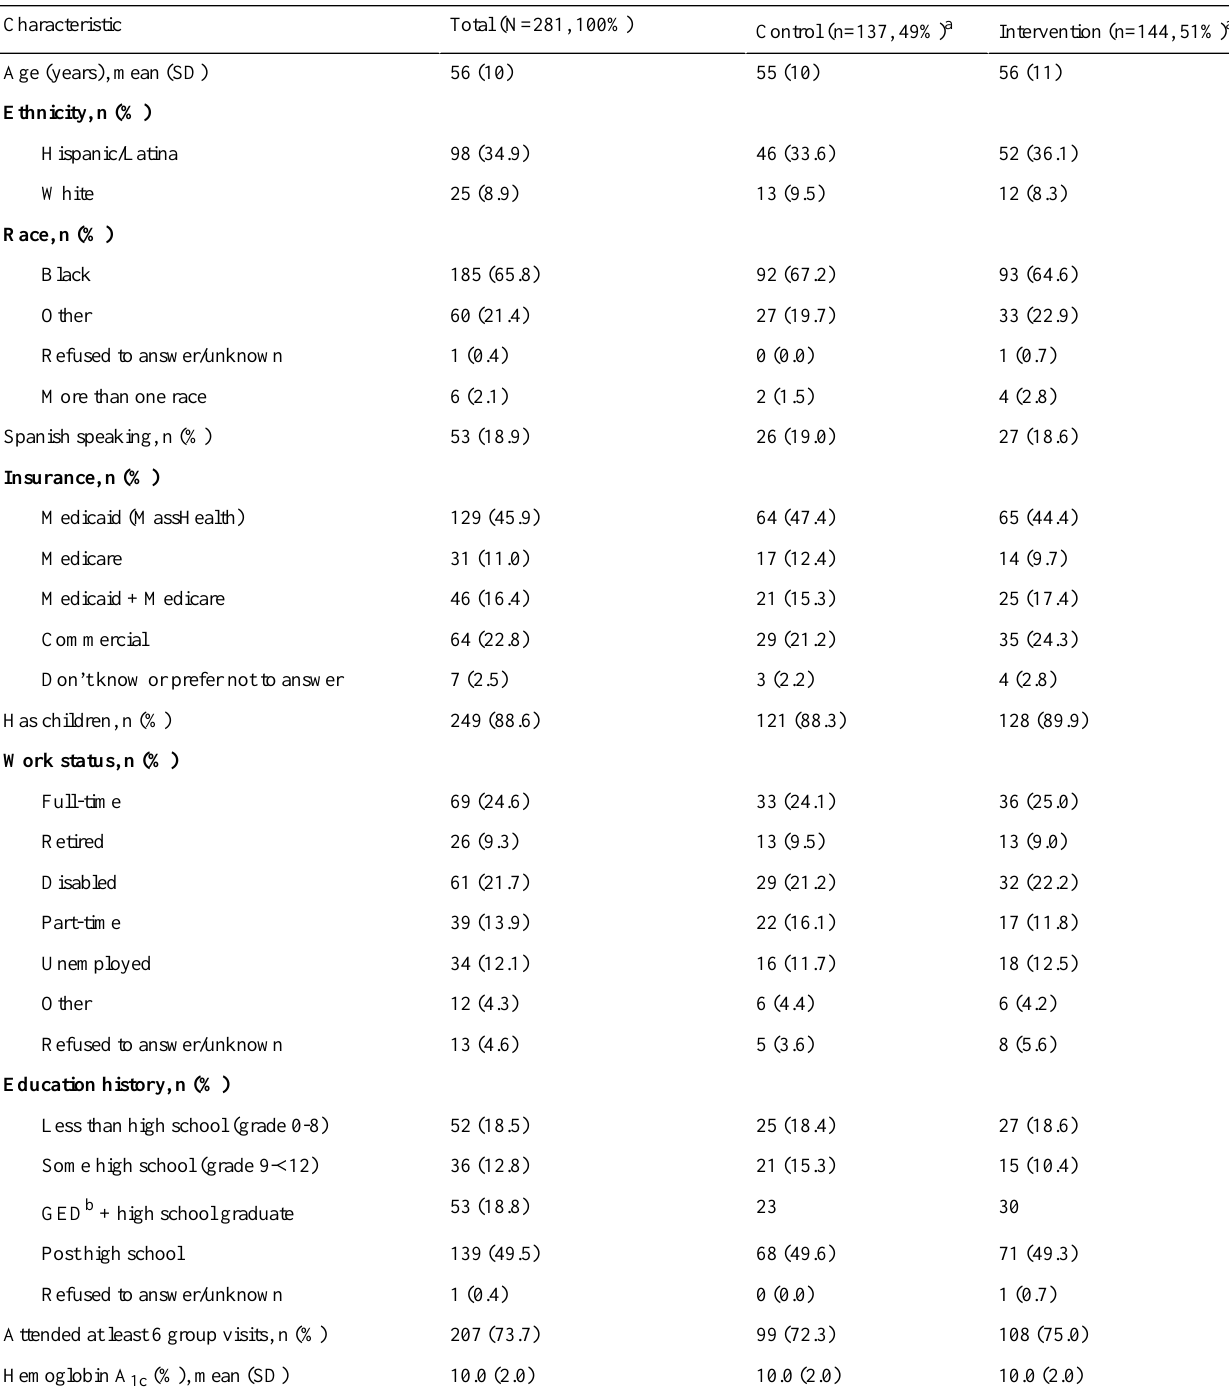
Table 1. Baseline sample characteristics